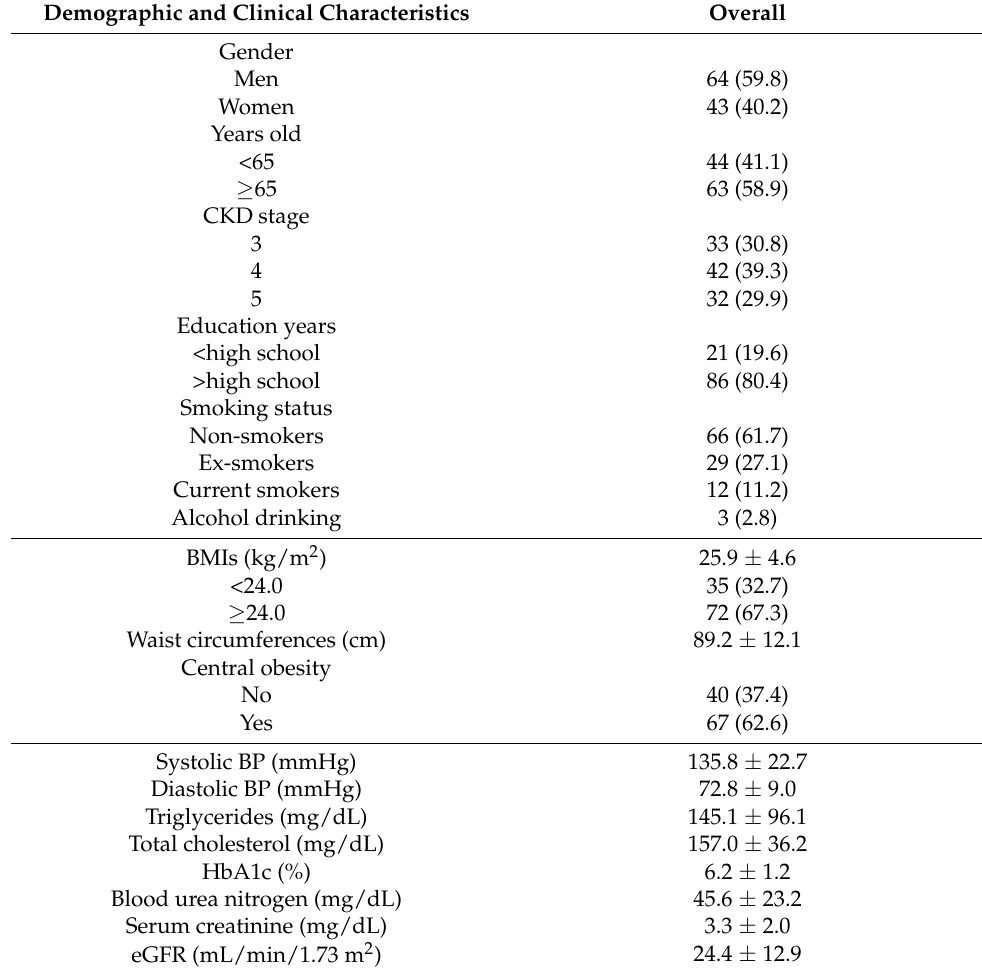
Table 1. Characteristics of 107 patients with chronic kidney disease (CKD). Demographic and Clinical